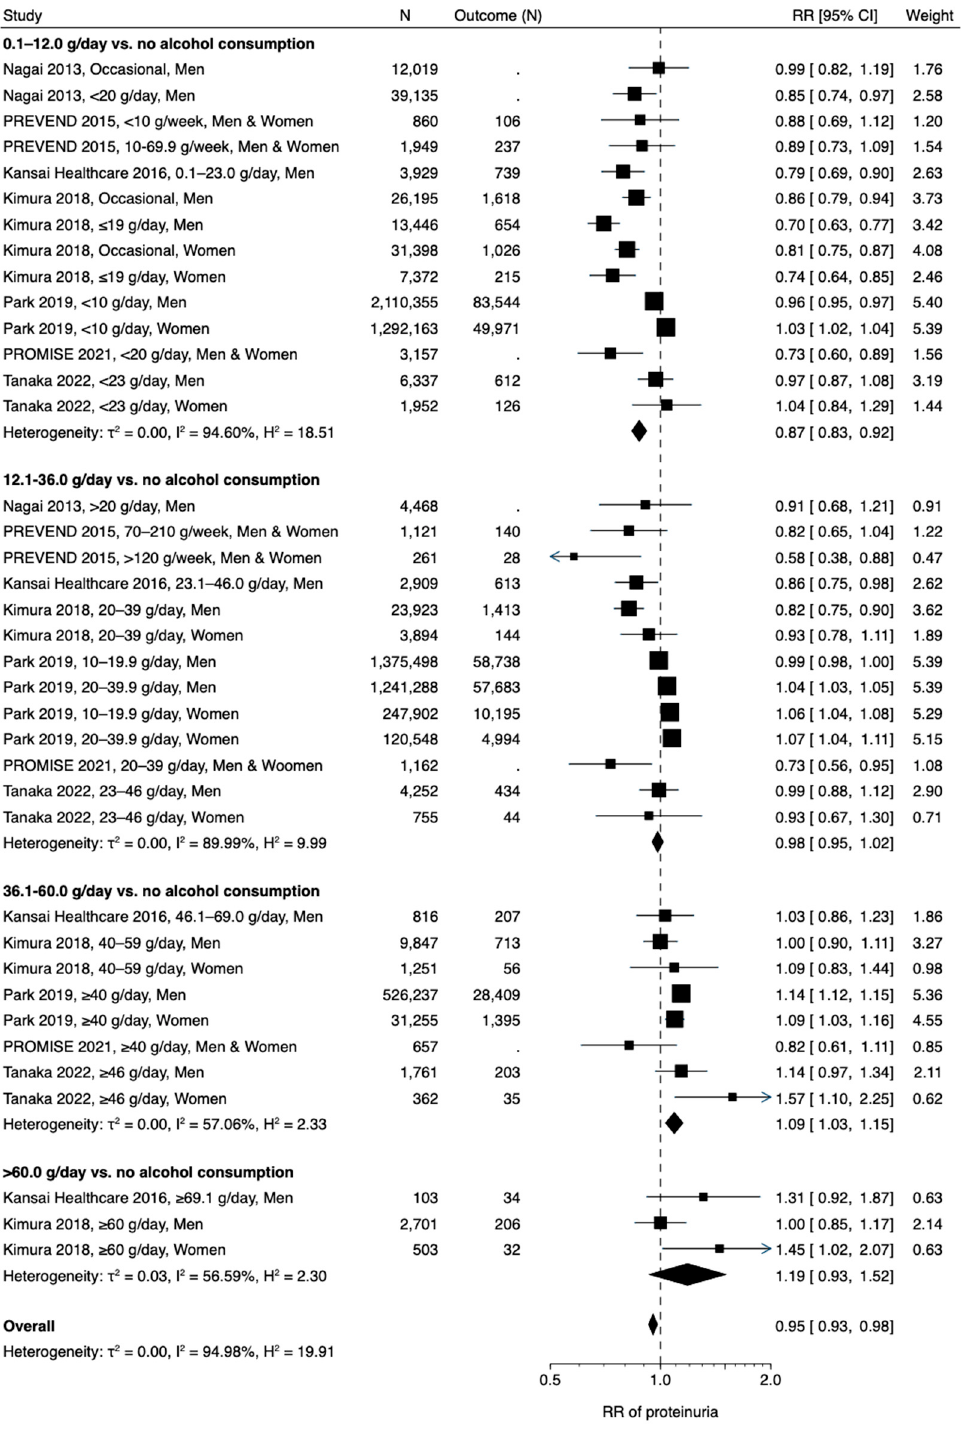
Figure 1. Alcohol consumption and incidence of proteinuria. CI, confidence interval; RR, relative risk [19–21,35,37,38,40].